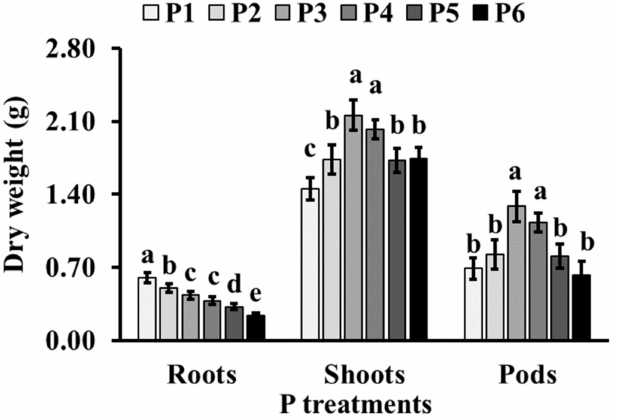
Figure 1. Effects of different P treatments on root, shoot, and pod dry weight in green bean plants at the end of the experiment. Means with the same lower-case letter are not significantly different at p < 0.05 according to LSD and one-way ANOVA. Error bars represent standard deviation of the means (SE), n =